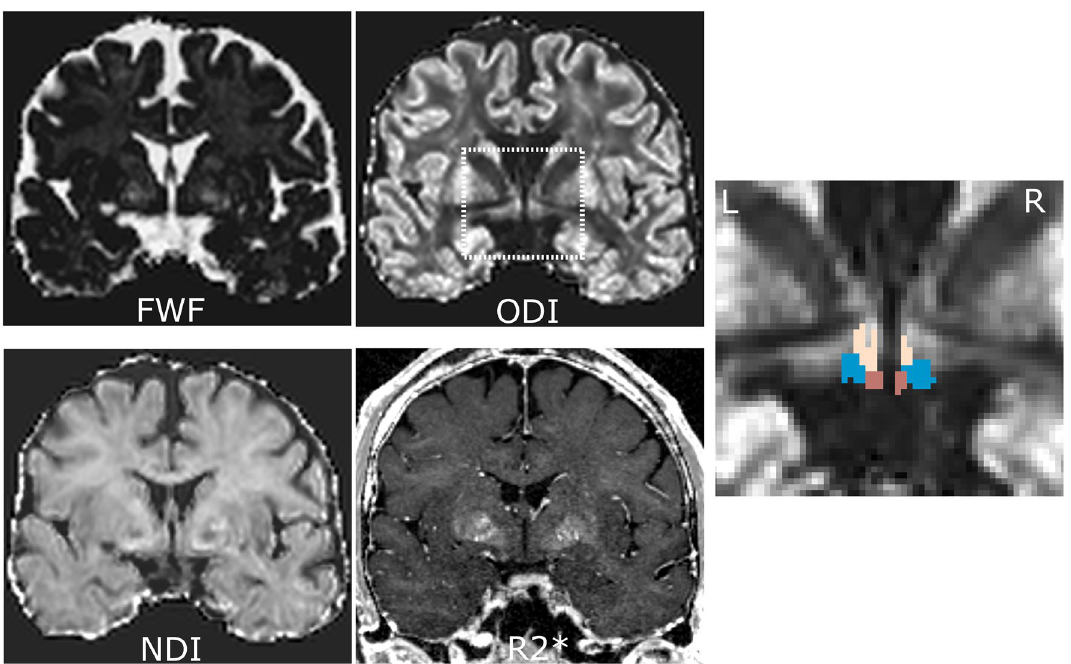
Figure 4. Exemplary dataset in native space displaying the four used MRI parameters in coronal view (FWF: free water fraction, ODI: orientation dispersion index corrected for FWF, NDI: neurite density index corrected for FWF, R2*: effective transverse relaxation rate), as well as the ODI image zoomed in on the hypothalamus area and overlaid with the hypothalamus masks after correction for confounding white matter (beige: superior, blue: intermediate, brown: posterior subunits). The inferior subunit is not visible on this